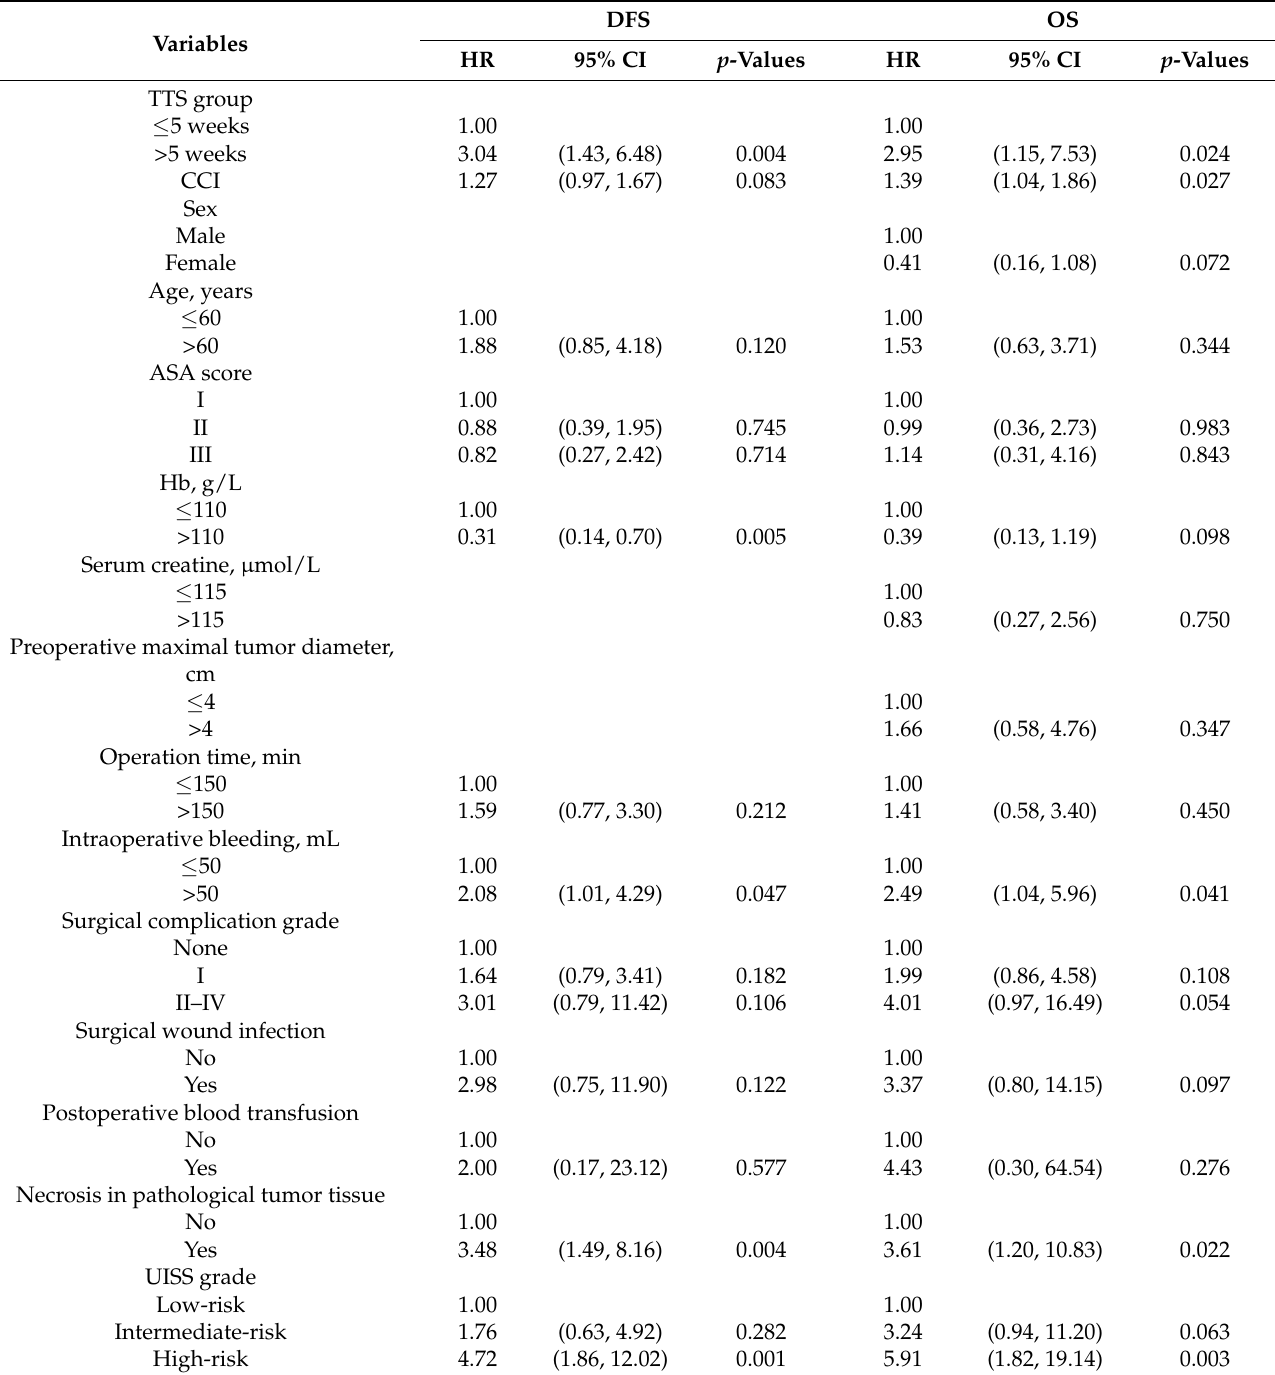
Table 4. Multivariable Cox regression for DFS and OS among T1b